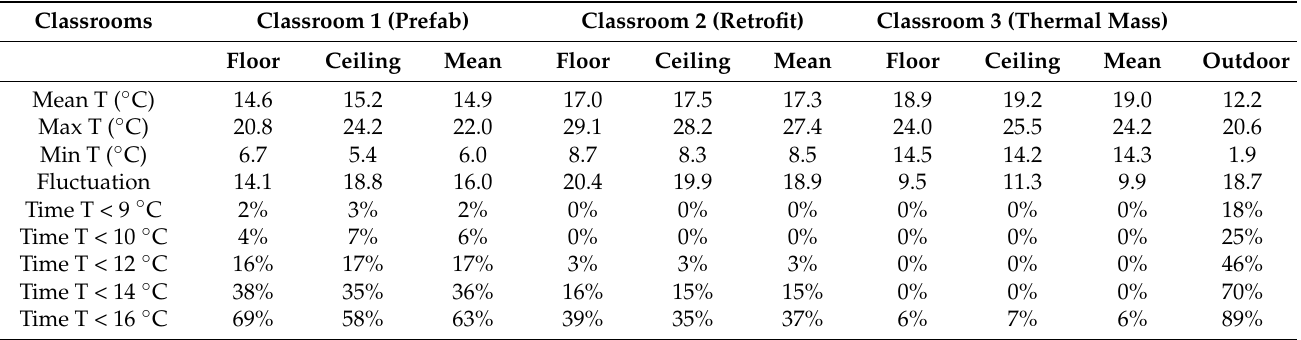
Table 5. Indoor temperature and pecentages of time related to different low temperature ranges throughout winter (24 h per